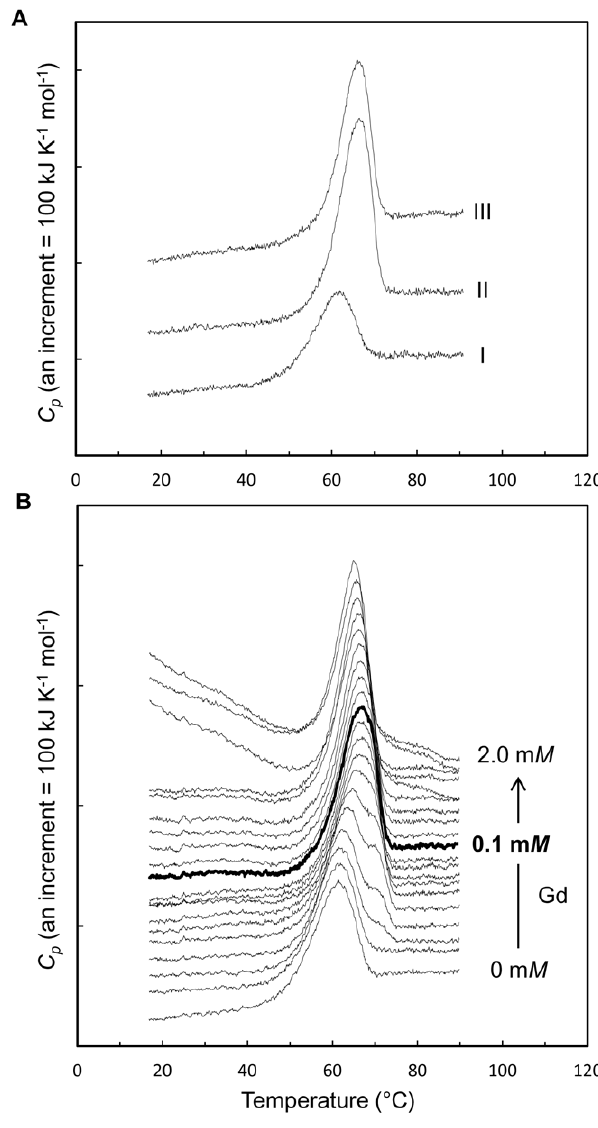
Figure 1. DSC curves of Ao a -amylase with heavy atoms at pH 5.8. (A) 0.2 mg/mL Ao a -amylase with heavy atoms. (I) no heavy atom, (II) 0.2 m M GdCl 3 , (III) 0.2 m M SmCl 3 . (B) Gd concentration dependence of the denaturation temperature of 0.4 mg/mL Ao a - amylase with 0–2.0 m M GdCl 3 (0, 0.01, 0.02, 0.03, 0.04, 0.05, 0.06, 0.07, 0.08, 0.09, 0.10, 0.11, 0.12, 0.15, 0.2, 0.3, 0.5, 0.9, 1.0, and 2.0 m M ). A concentration of 0.1 m M GdCl 3 gave the highest T d value, 67.3 u C (heavy line). The denaturation temperature, T d , represents the temperature corresponding to the peak of the DSC curve observed at a scan rate of 200 u